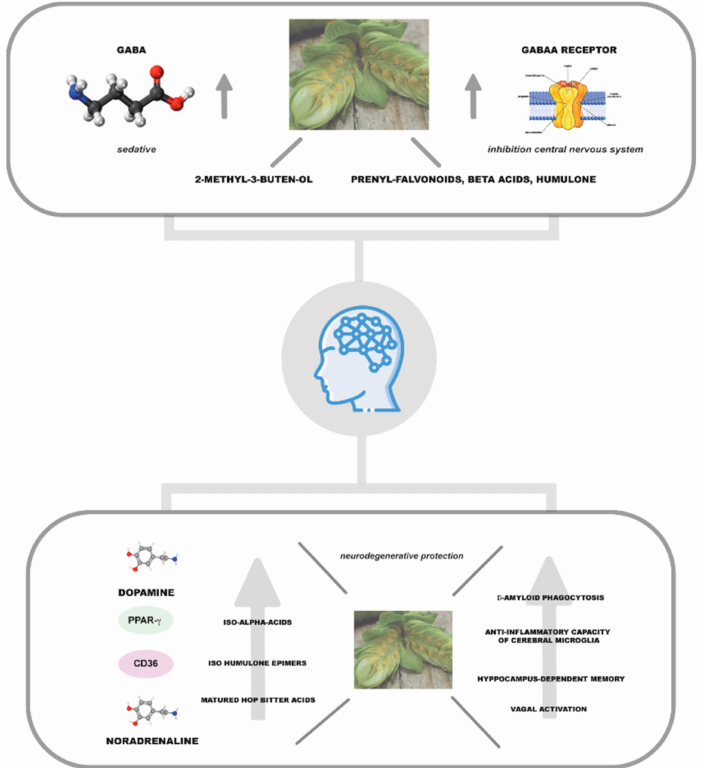
Figure 4. Bioactive compounds and molecular targets involved in the neuroprotective potential of Humulus lupulus L. The GABA structure is from https://es.wikipedia.org/wiki/Ácido_ γ -aminobutírico (accessed on 21 November 2022); the GABA A receptor is from David M. Lovinger, Public domain, via Wikimedia Commons https://upload.wikimedia.org/wikipedia/commons/3/3a/GABAa_receptor.gif (Last accessed on 21 November 2022). This illustration was designed using images from